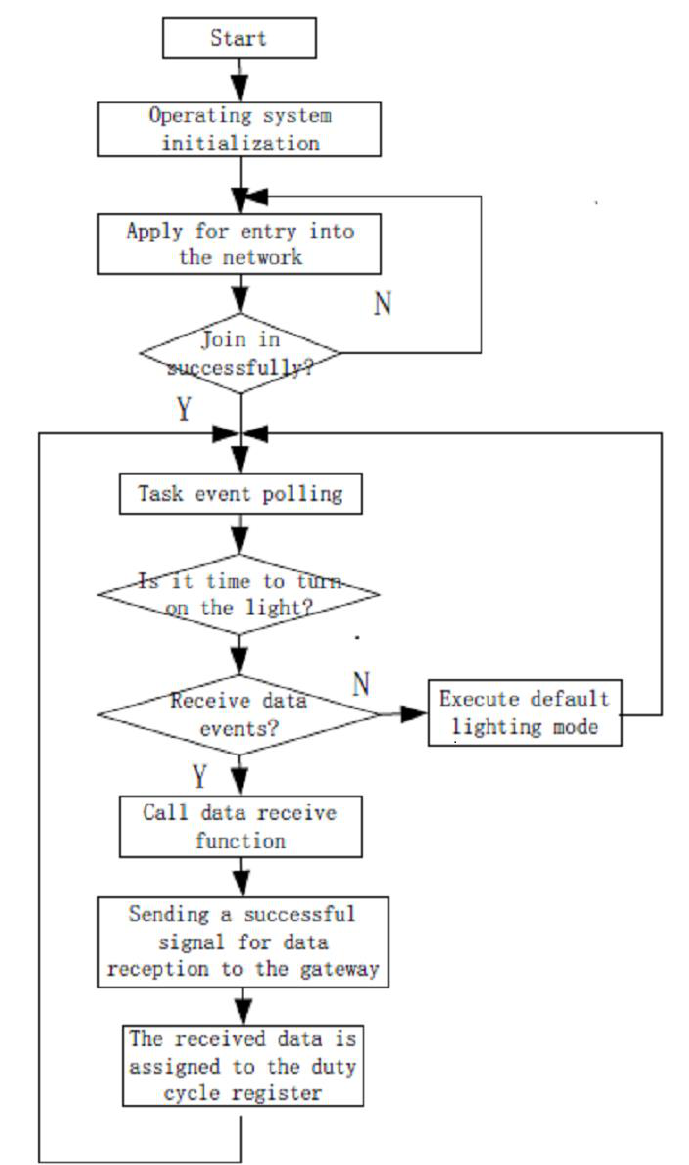
Fig. 4. Flow chart of controller